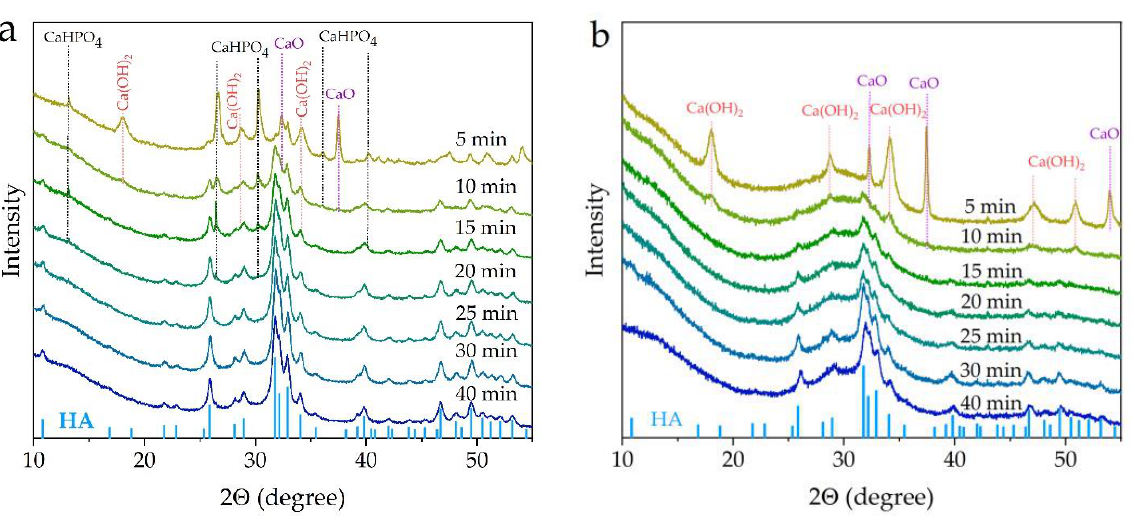
Figure 1. XRD patterns of 1.0-ZnSi-HA ( a ) and 2.0-ZnSi-HA ( b ) samples after different mechanical treatment times.